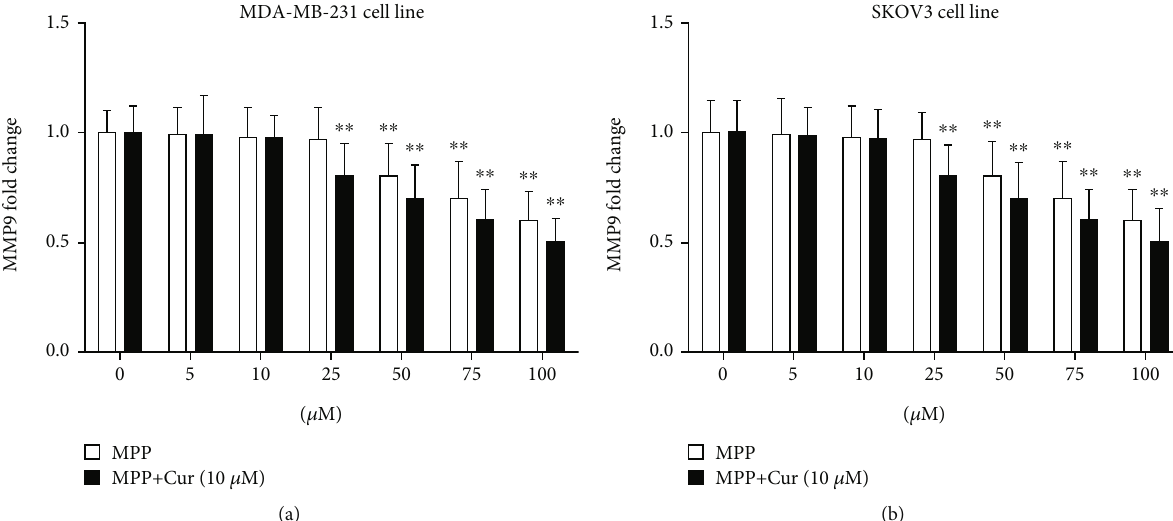
Figure 7: The expression of MMP9 gene in (a) MDA-MB-231 and (b) SKOV3 cell lines, measured by real-time PCR. ∗∗ P < 0 : 01 compared with untreated control cells. The results summarize the data of three separate